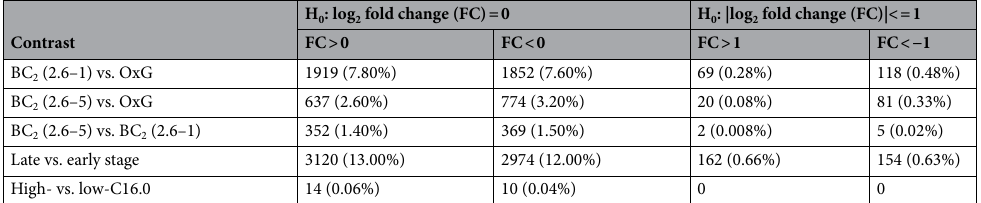
Table 2. The number of genes with a significant change in expression among the OxG, BC 2 (2.6–1) and (2.6– 5) populations, mesocarp developmental stages (late and early) and C16.0 content (high and low). Significant DEGs at adjusted p value < 0.01 are presented for up-regulation (FC > 0 and > 1) and down-regulation (FC < 0 and < −1).